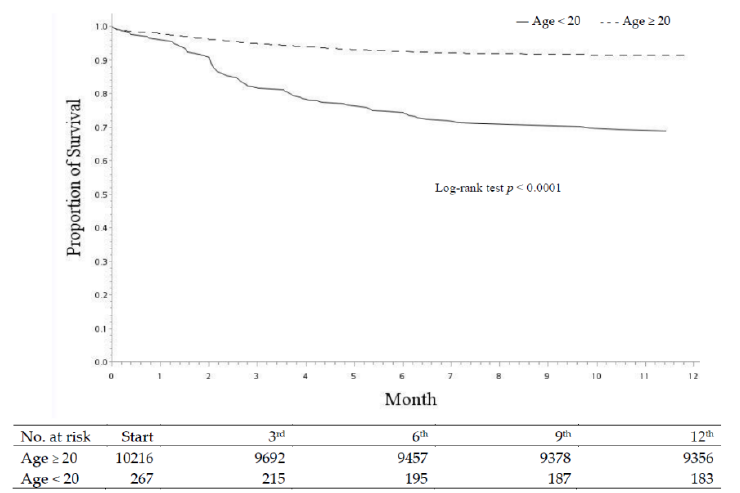
Figure 3. Proportion of survival of offspring between the maternal age ≥ 20 and < 20 years cohorts.